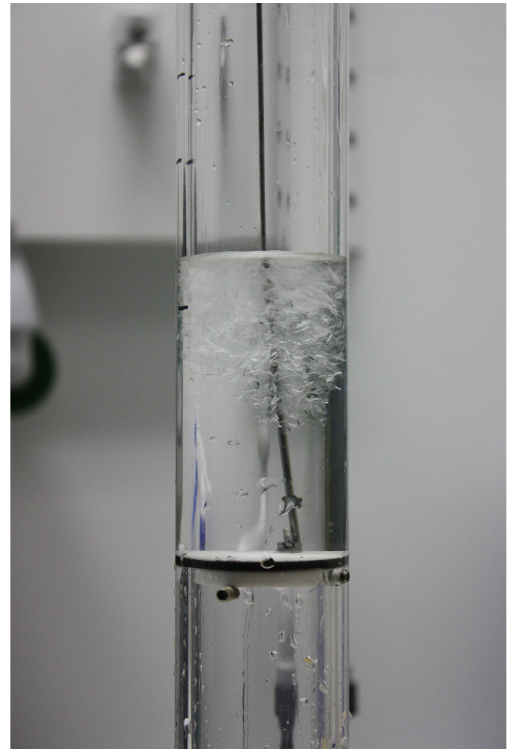
Fig. 2. Photo of the sampling device with the circular plate in hori- zontal position keeping the sampled grease ice trapped in the